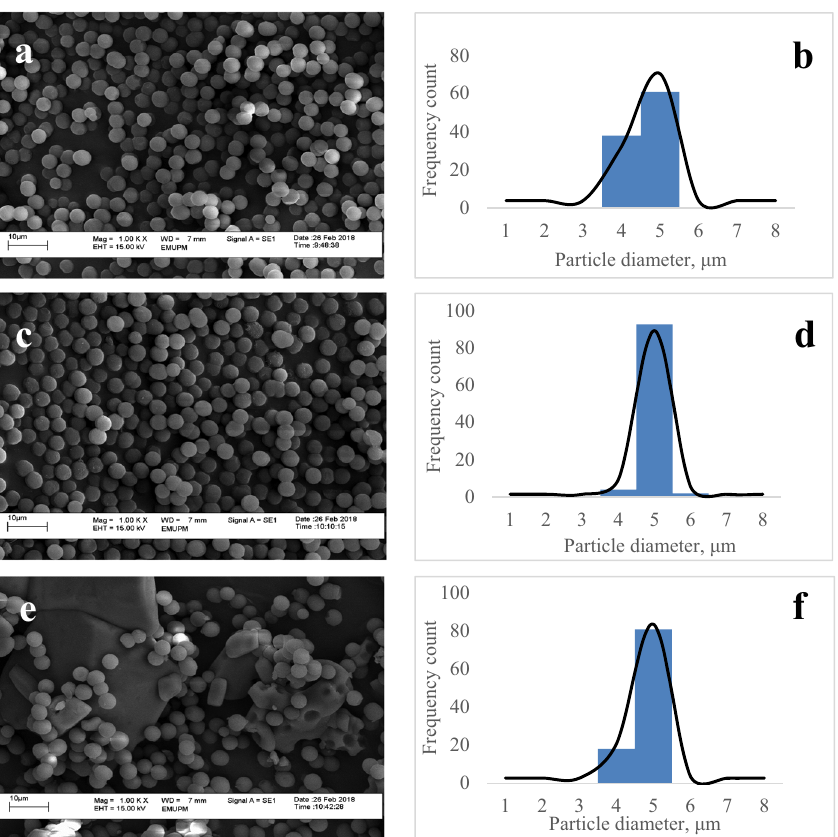
Figure 3: SEM images and polynomial distribution: ( a ) SEM image of P1, ( b ) polynomial distribution of P1, ( c ) SEM image of HXL P1, ( d ) polynomial distribution of HXL P1, ( e ) SEM image of EDA - HXL P1, and ( f ) polynomial distribution of EDA - HXL